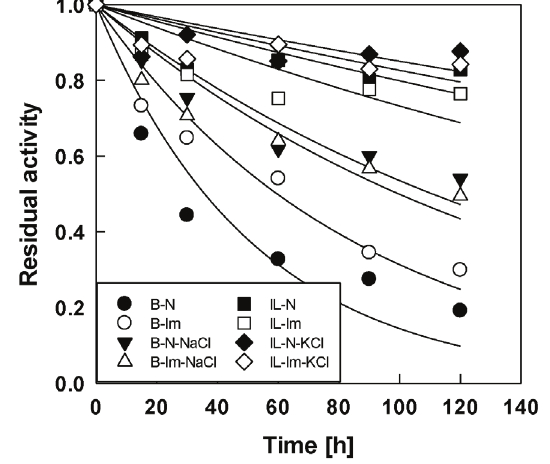
Fig. 4 – Effect of vinyl acetate concentration and treatment of lipase on initial rate of transesterification; [BA] = 20 mol m –3 . Solid lines are calculated by Eq. (1). Key legends are identical to those in Fig. 3.